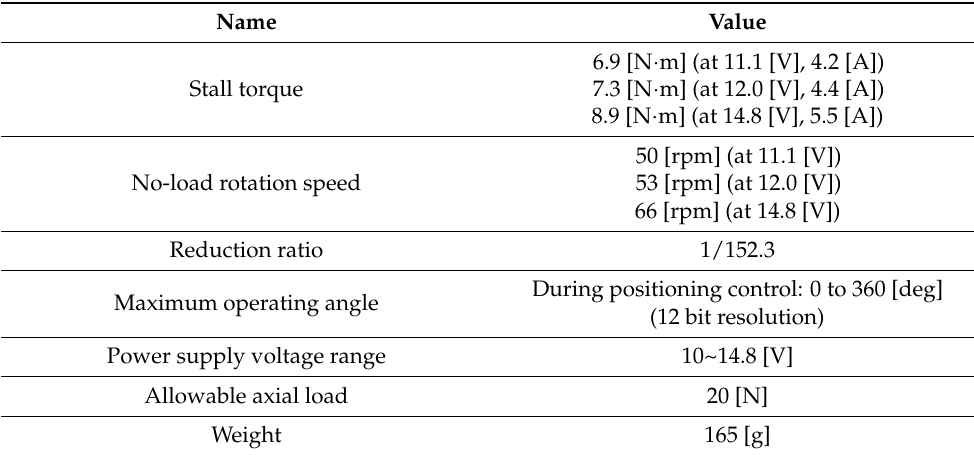
Table 2. The specifications of XM540 ‐ W150 ‐ T.